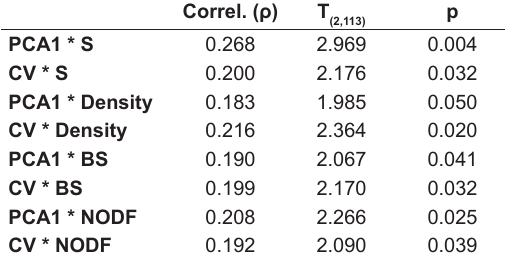
PCA1 = Axis 1 scores of PCA; CV = coefficient of variation; S = species richness; BS = Biodiversity